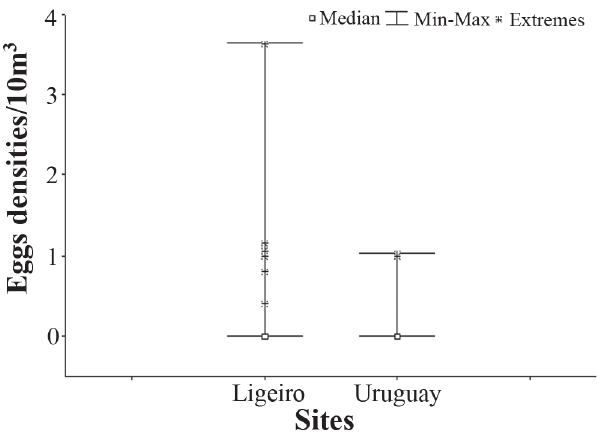
Fig 2. Density of eggs (transformed by 4 density egg ) captured